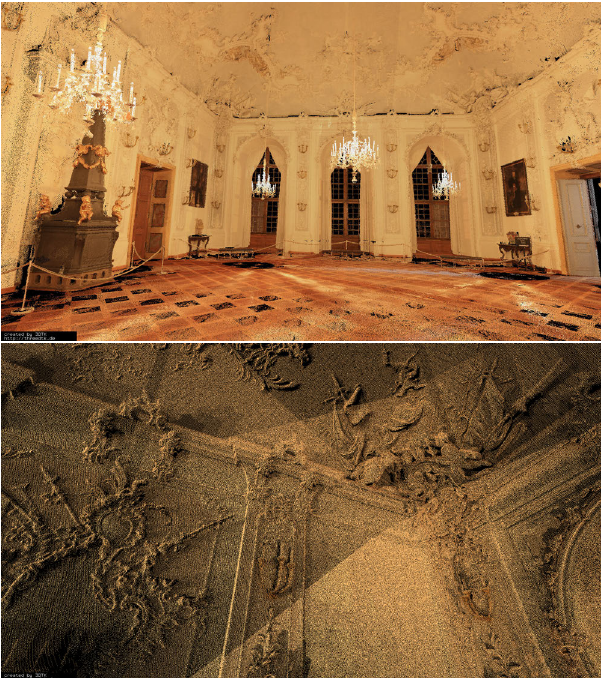
Figure 11: Reconstruction of the White Hall in the W¨urzburg Residence. In the close-up view the impressive stucco work is clearly